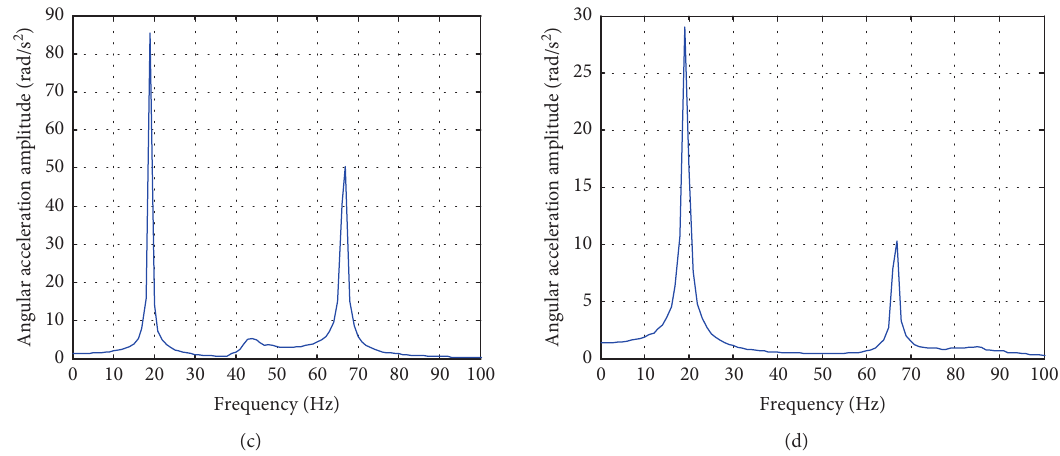
Figure 15: Spectra of J 8 and J 10 at 2000r/min of engine speed: (a) spectrum of J 8 and (b) spectrum of J 10 of DMF; (c) spectrum of J 10 of DMF with simple CPVA; (d) spectrum of J 10 of DMF with bifilar CPVA.